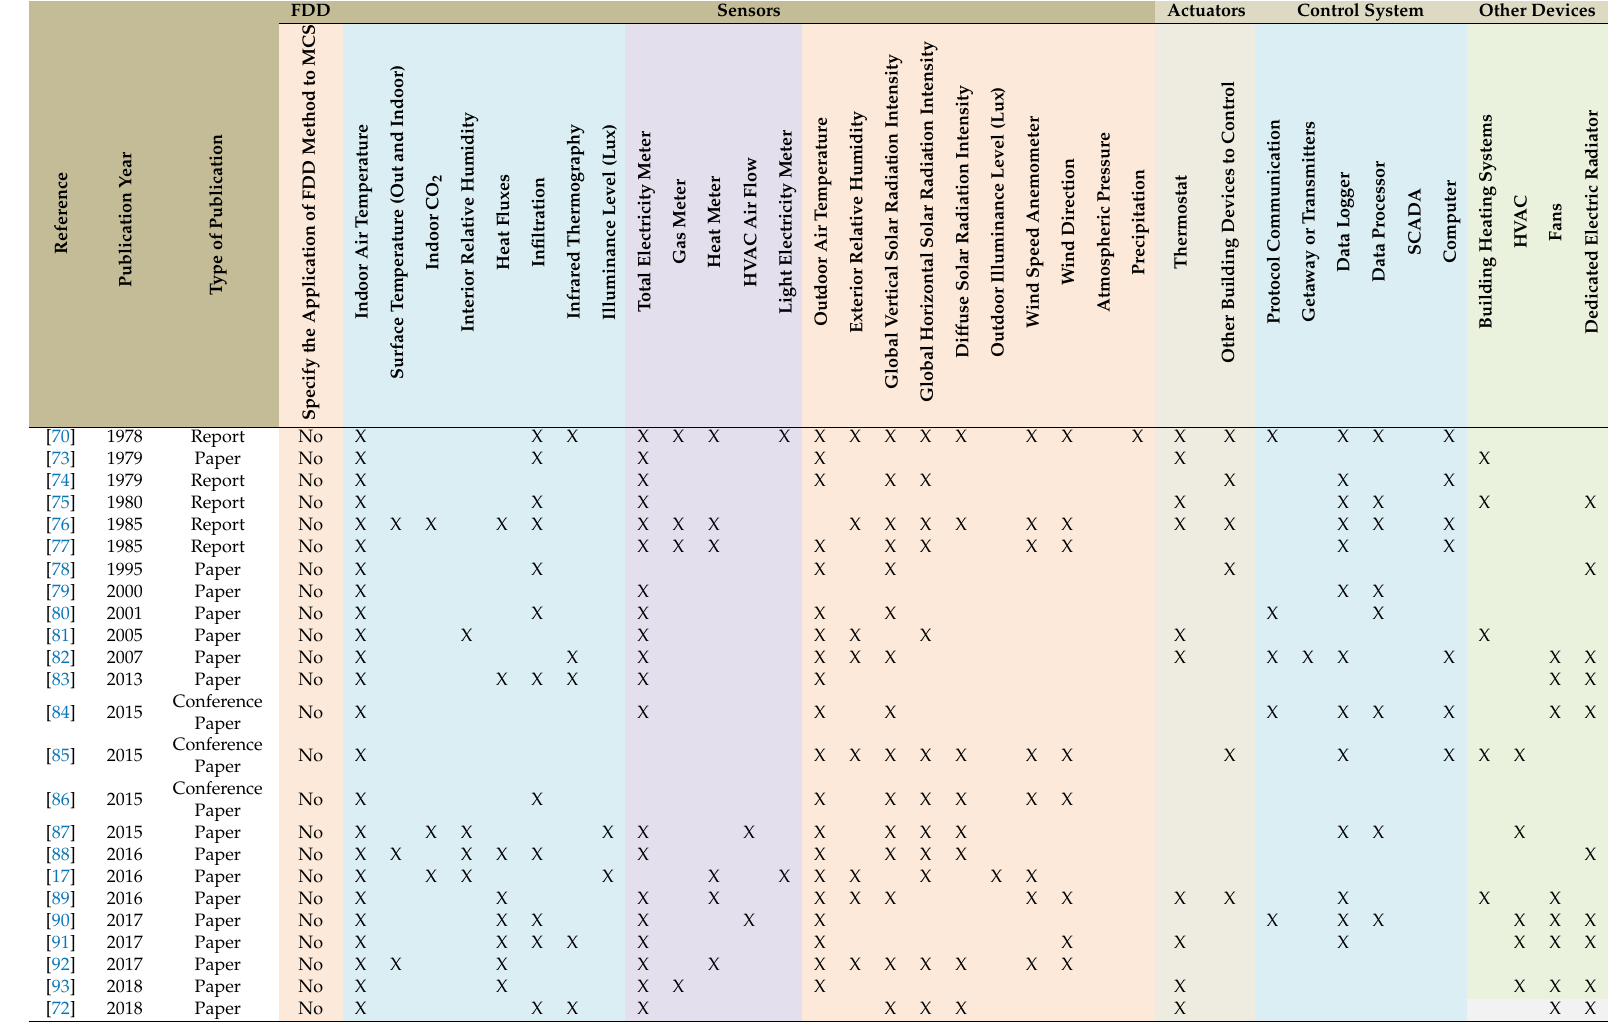
Table 9. MCSs in the reviewed literature from 1979–2018, specified by the authors to characterize the TEP of buildings. FDD Sensors Actuators Control System Other